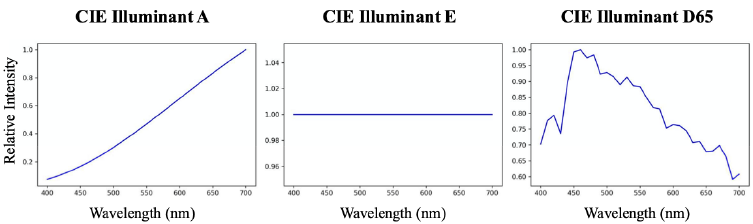
Figure 11. Target illuminants for scene relighting: CIE Illuminants A ( left ), E ( middle ) and D65 ( right ).